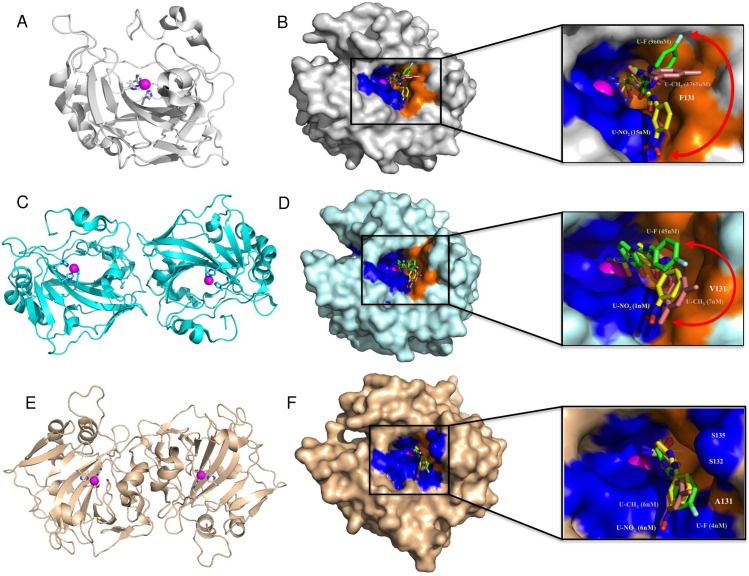
USBs bound in the active site of CAs.Panel A. Ribbon diagram of monomeric CA isoform II (gray). Panel C. Ribbon diagram of the catalytic domains of dimeric CA isoform IX (cyan). Panel E. Ribbon diagram of the catalytic domains of dimeric CA isoform XII (wheat). Surface representation of compounds U-CH3 (pink), U-F (green) and U-NO2 (yellow) in complex with monomers of CA II (Panel B), the CA IX-mimic (Panel D), and modeled into the active site of CA XII (Panel F). Catalytic zinc (magenta sphere), hydrophilic (blue) and hydrophobic (orange) residues are as shown. Red double-headed arrows indicate isoform specificity relative to residue 131 (labeled in white). These arrows also show flexibility in tail conformations seen in CA II and CA IX but not in CA XII. Previously published Ki values of each compound bound to purified CA II, CA IX and CA XII are noted next to the inhibitor name [67, 68]. Figures were designed using PyMol.